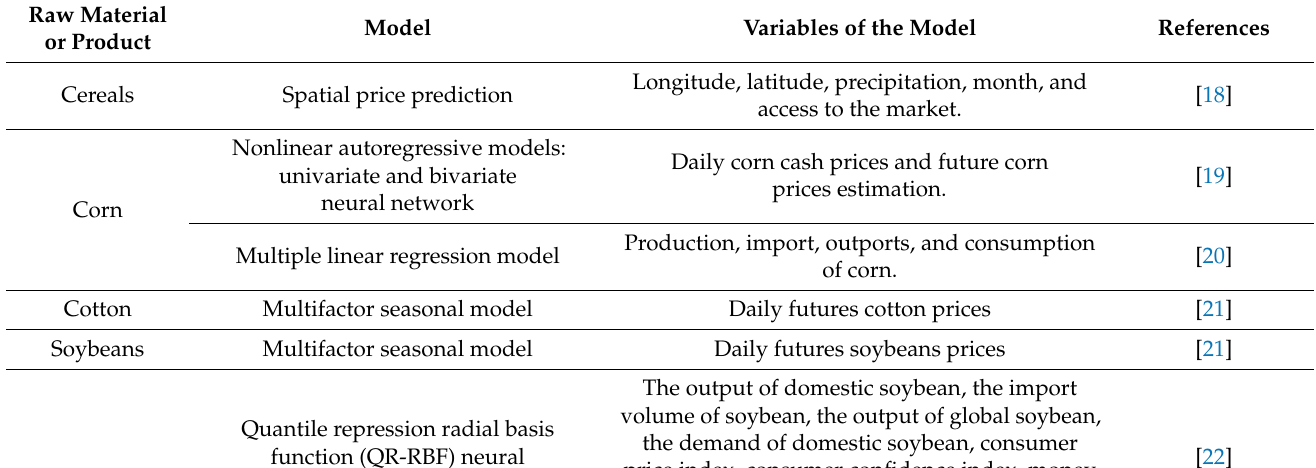
Table 1. Summary of models for price prediction of raw materials and